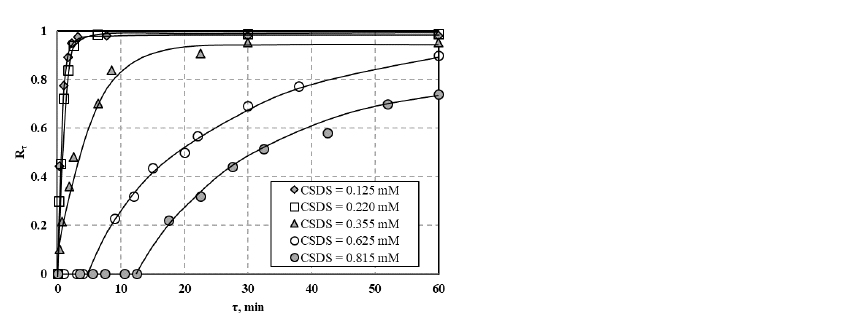
Figure A14. Changes in Cu(II) temporary removal ratio during precipitate flotation from solution containing Al(III), Cu(II), and Zn(II) mixture—effect of collector concentration (c 0 = 0.15 mmol dm − 3 , pH = 8.0, u G = 1.51 mm s − 1 ).